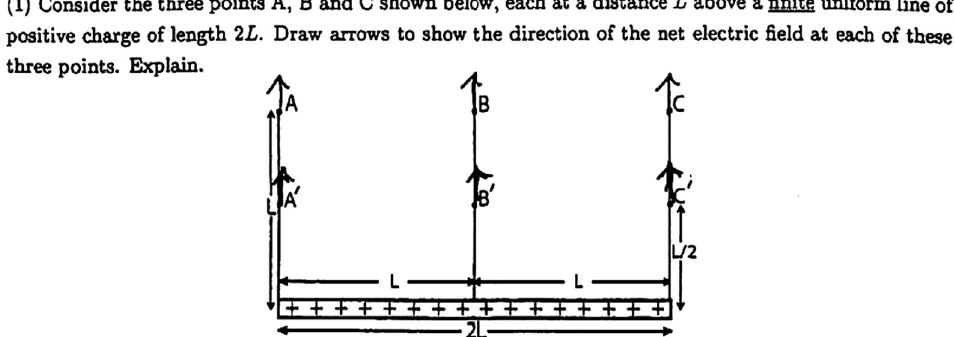
FIG. 1. A sample response from a student for pretest questions (1) and (2) for the direction of the field at the points shown.